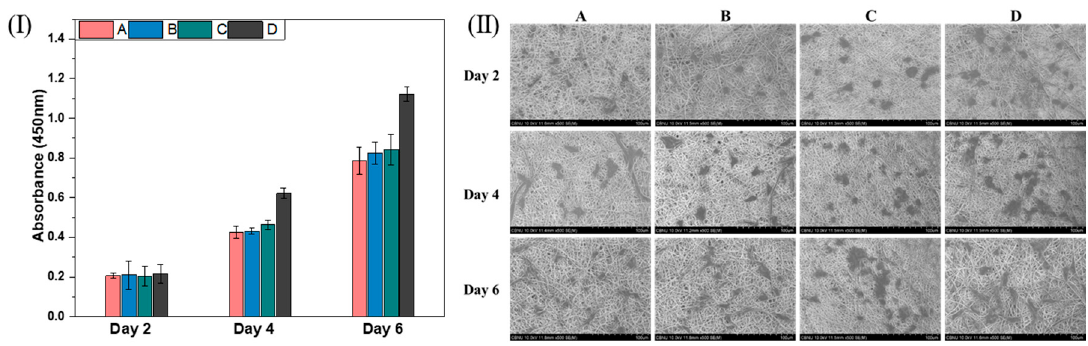
Figure 4. ( I ) CCK-8 assay show proliferation of MC3T3-E1 cells, ( II ) FE-SEM images of MC3T3-E1 ( B ) PCL-PGS, ( C ) PCL-PGS-HA, ( D ) PCL-PGS-HA-SIM. cells cultured on different nanofibrous mats. The cells were seeded for 2, 4 and 6 days. ( A ) PCL, ( B ) PCL-PGS, ( C ) PCL-PGS-HA, ( D ) PCL-PGS-HA-SIM.